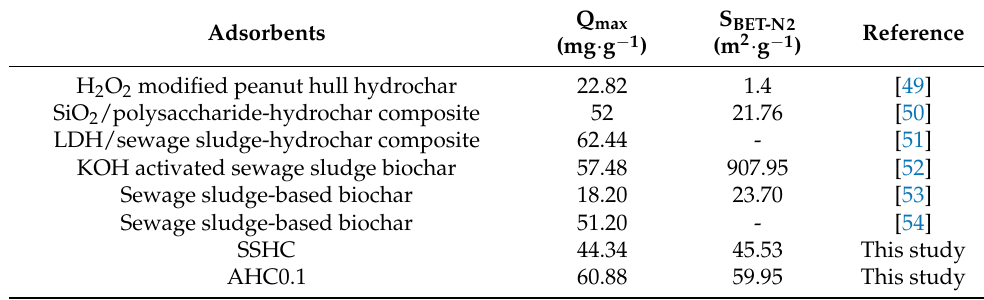
Ⅱ ) onto various adsorbents.